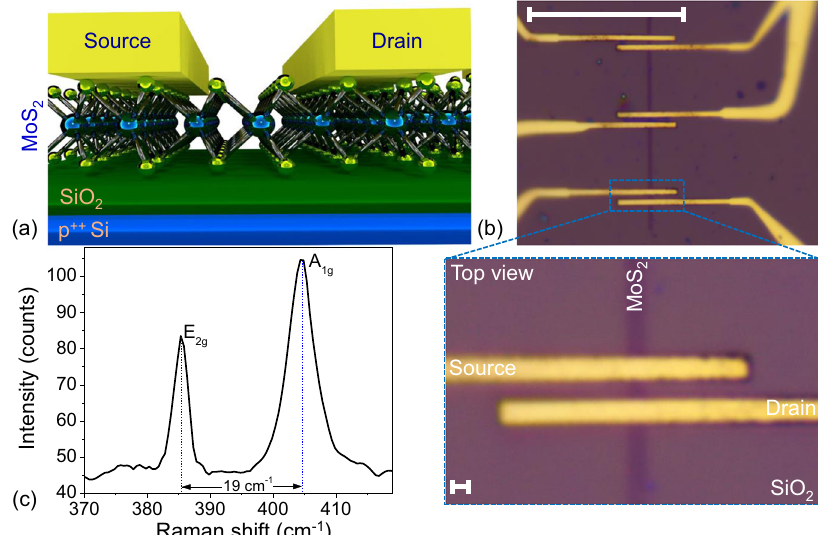
Fig. 1 Device con fi guration and monolayer identi fi cation. a Schematic of the back-gated transistor con fi guration used in this work. b Optical image of the top view of as-fabricated back-gated devices on MoS 2 (scale bar: 20 µ m). Inset: magni fi ed image of the bottom-most device (scale bar: 1 µ m). c Preliminary material characterization through Raman spectra of the MoS 2 channel showing a separation of ~19 cm – 1 between in-plane (E 2g ) and out-of-plane (A 1g ) modes that implies the presence of monolayer MoS 2 channel.